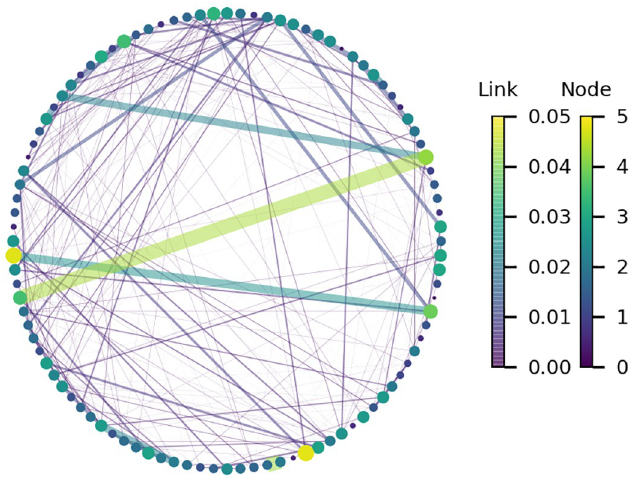
Fig 6. Subset of a contact network showing weighted node degree and interaction strength between nodes. Network generated using mobility data from February 10th. The node attribute is the weighted node degree, κ i , and the link attribute is interaction strength between nodes, κ . Line thickness and node diameter correspond to node ij degree and interaction strength.